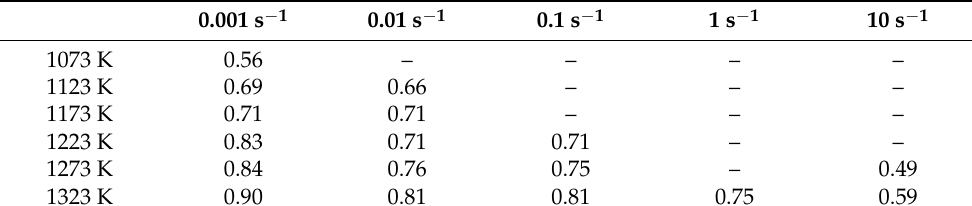
Table 2. The R-value at different temperatures and strain rates.